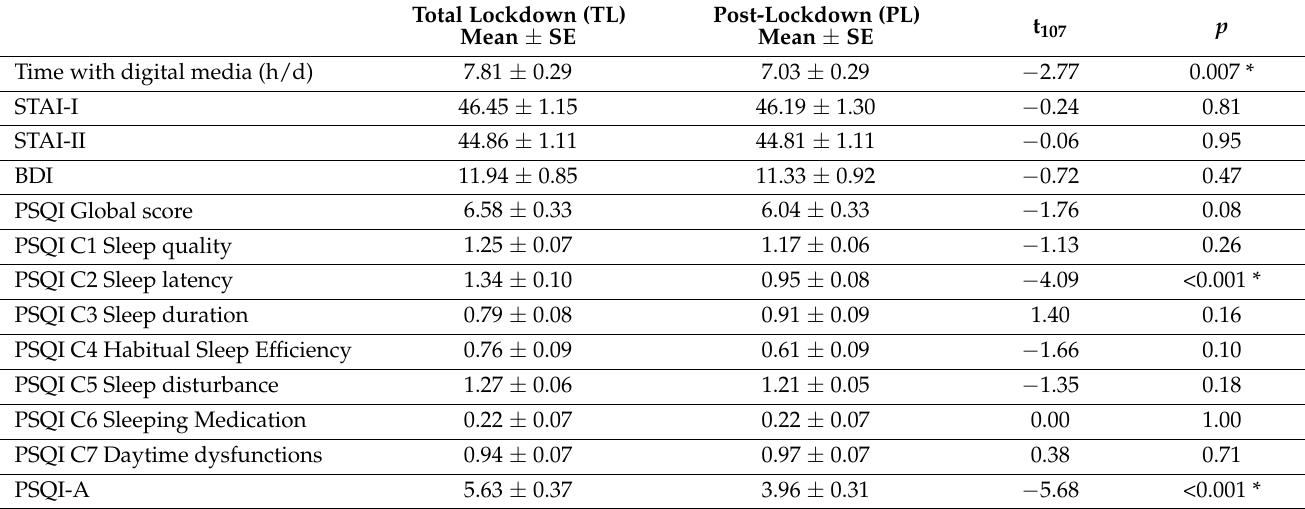
Table 4. Results of the comparisons (paired t -tests) between total lockdown (TL) and post-lockdown (PL) clinical, sleep, and digital media usage measures. Mean and standard errors (SE) are reported. Asterisks index significant differences ( p <